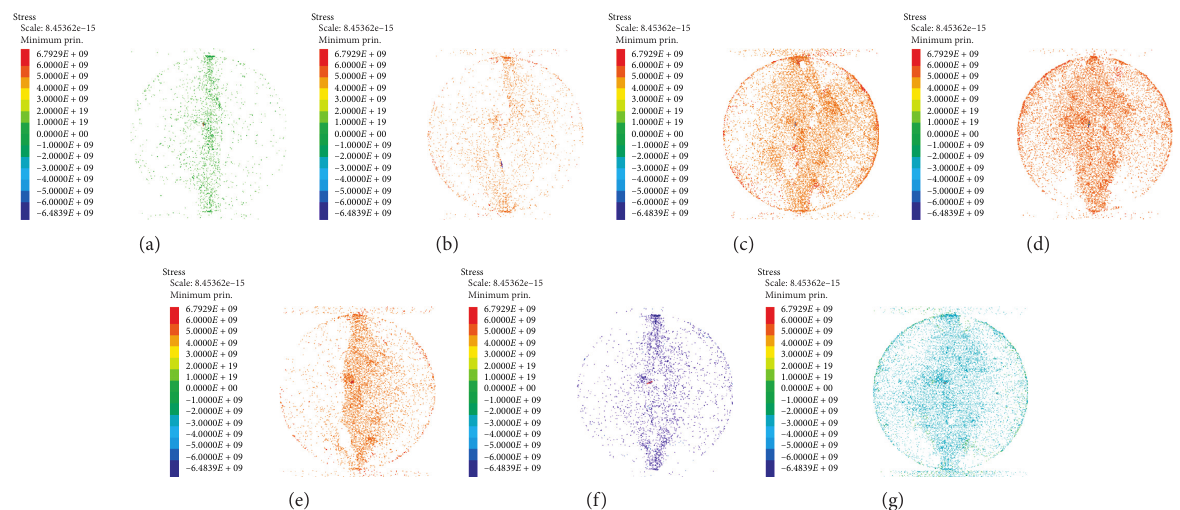
Figure 13: Loaded stress cloud with uneven parallel bedding model at different angles. (a) 0 ° . (b) 15 ° . (c) 30 ° . (d) 45 ° . (e) 60 ° . (f) 75 ° . (g) 90 ° .